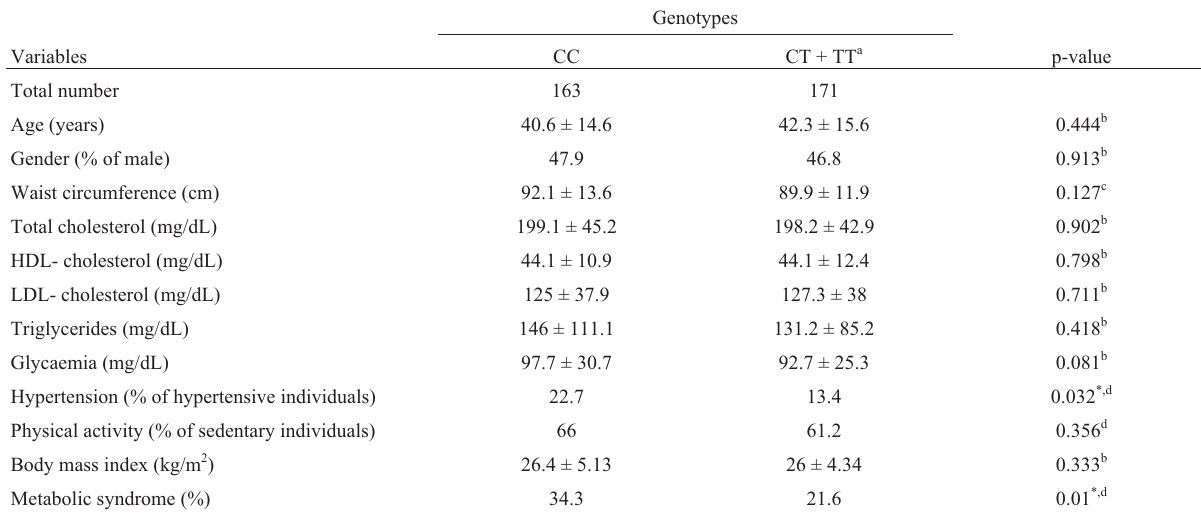
Table 1 - Demographic, laboratory and clinical characteristics of the investigated sample stratified by genotype.